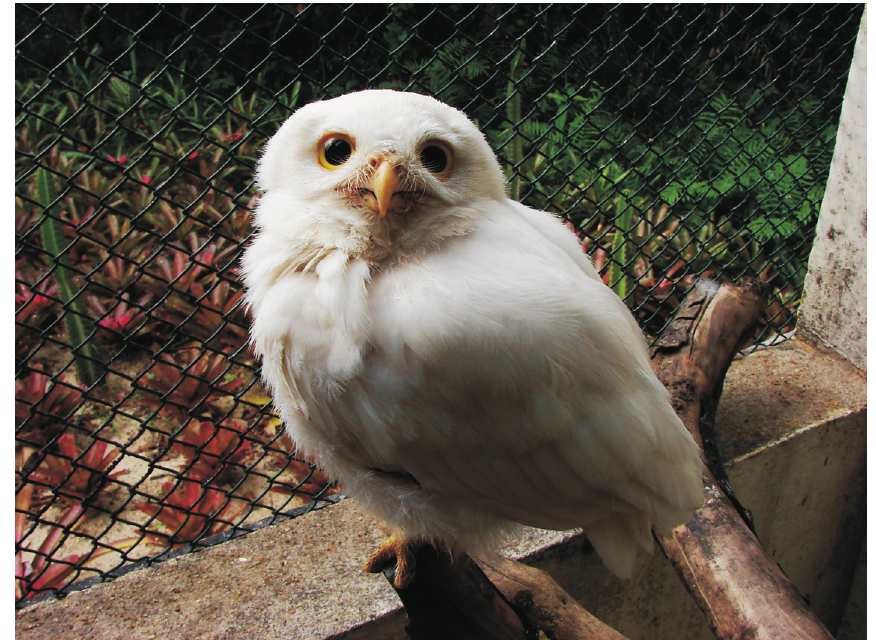
Figure 1. Leucistic A. cunicularia , pure white with eyes, beak and legs of normal coloring, found in the Rio das Ostras vivarium, Rio de Janeiro. Photo: Edvandro A.